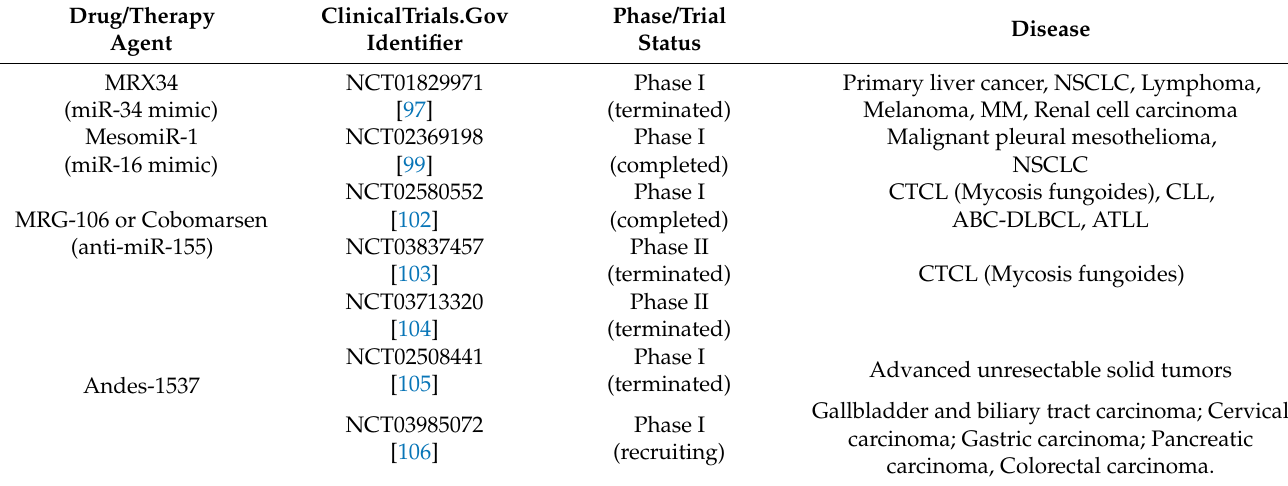
Table 2. miRNA and lncRNA-based therapies in clinical